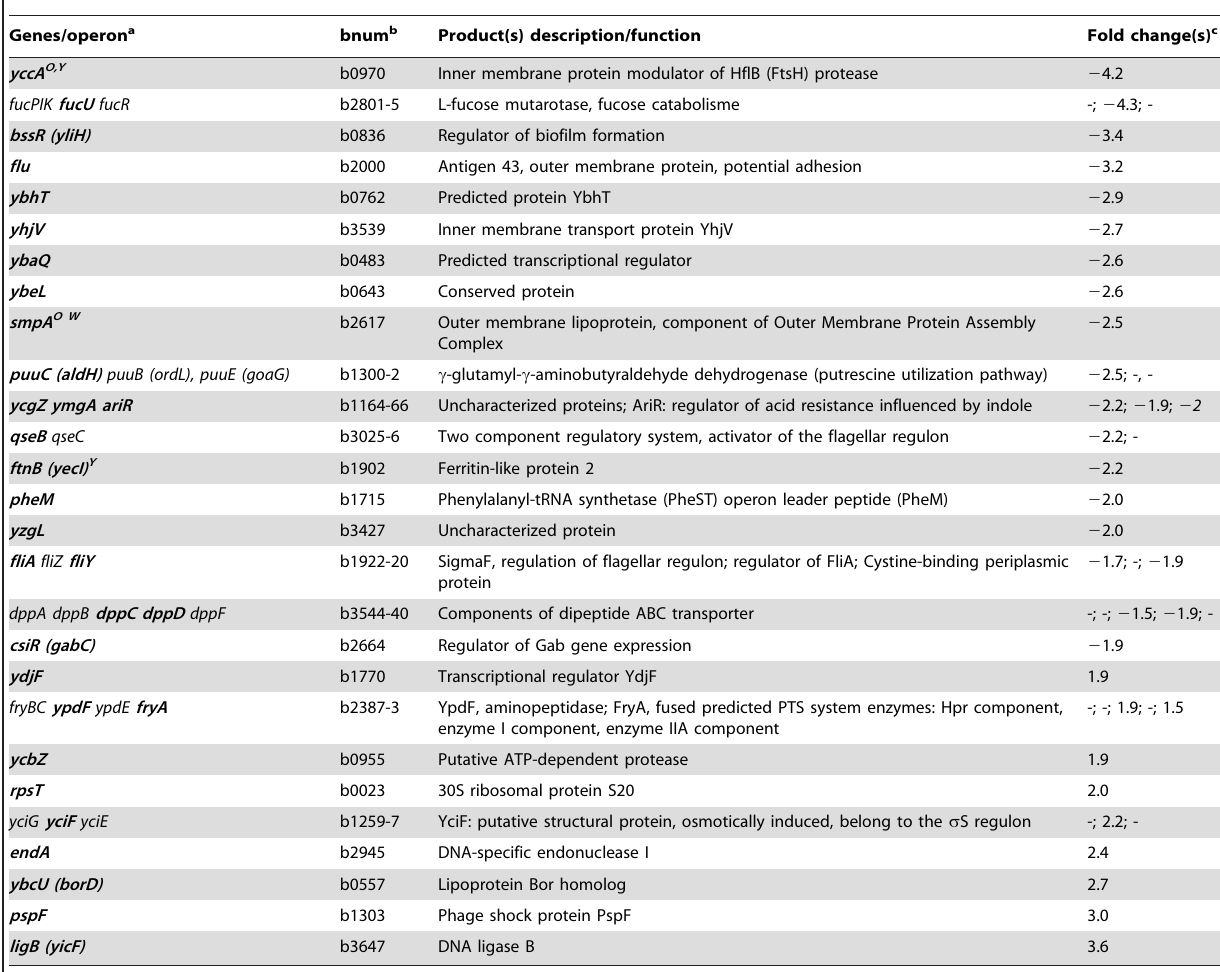
Table 7. Genes whose expression is significantly modulated by the absence of